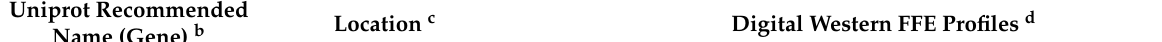
Table 4. Digital western FFE profiles of markers localized to chloroplast envelope and thylakoid membranes a .